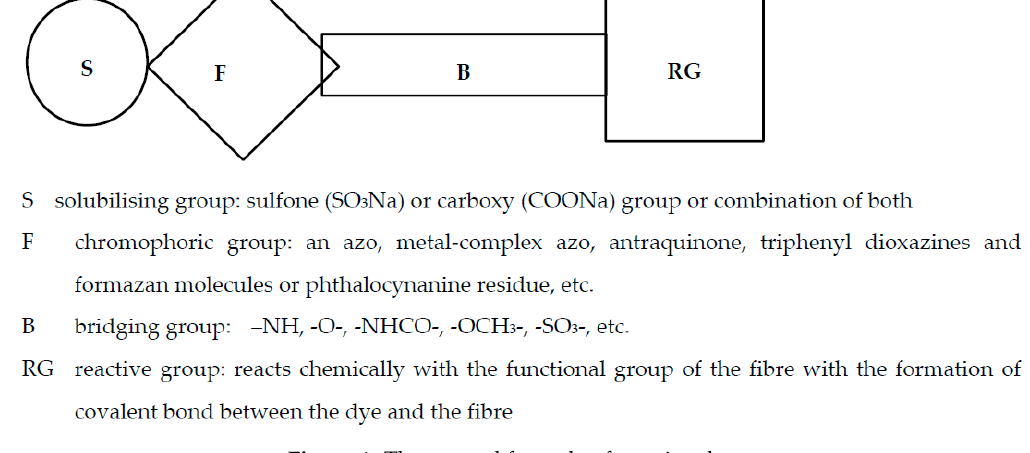
Figure 1. The general formula of reactive dyes.